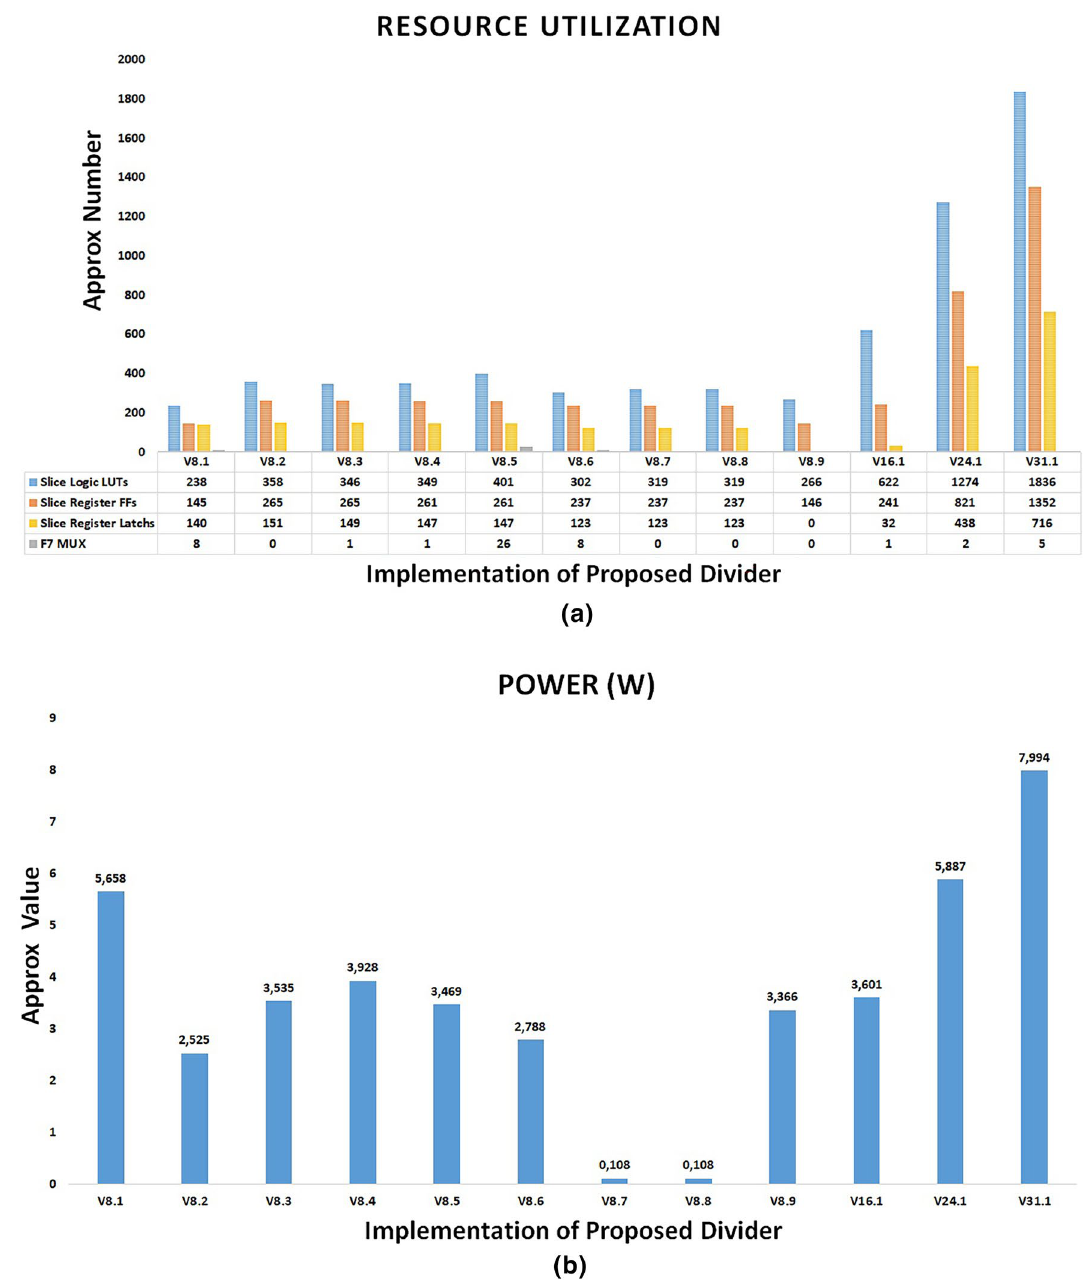
Figure 7. Hardware resource utilization of the proposed USP-Awadhoot algorithm-based